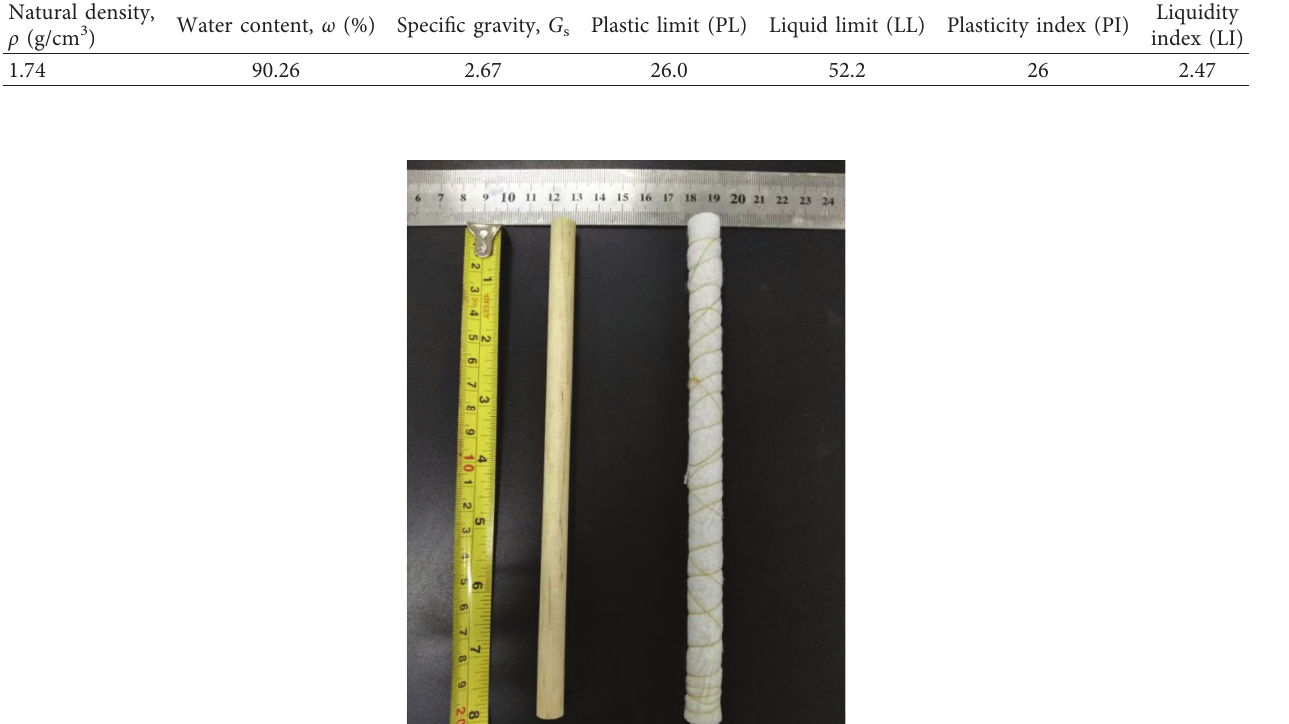
Table 1: Physical properties of the mucky clay used in the test.